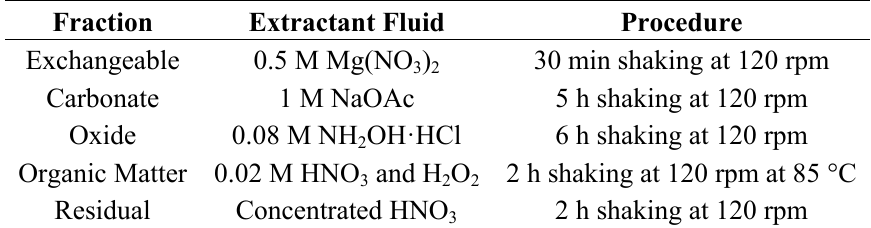
Table 1. Sequential chemical fraction procedure, modified from Tessier et al.